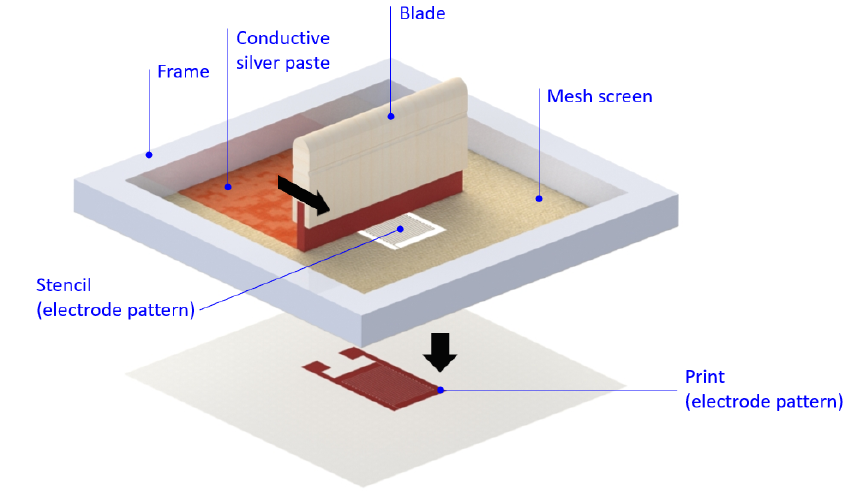
Figure 7. The screen printing process.